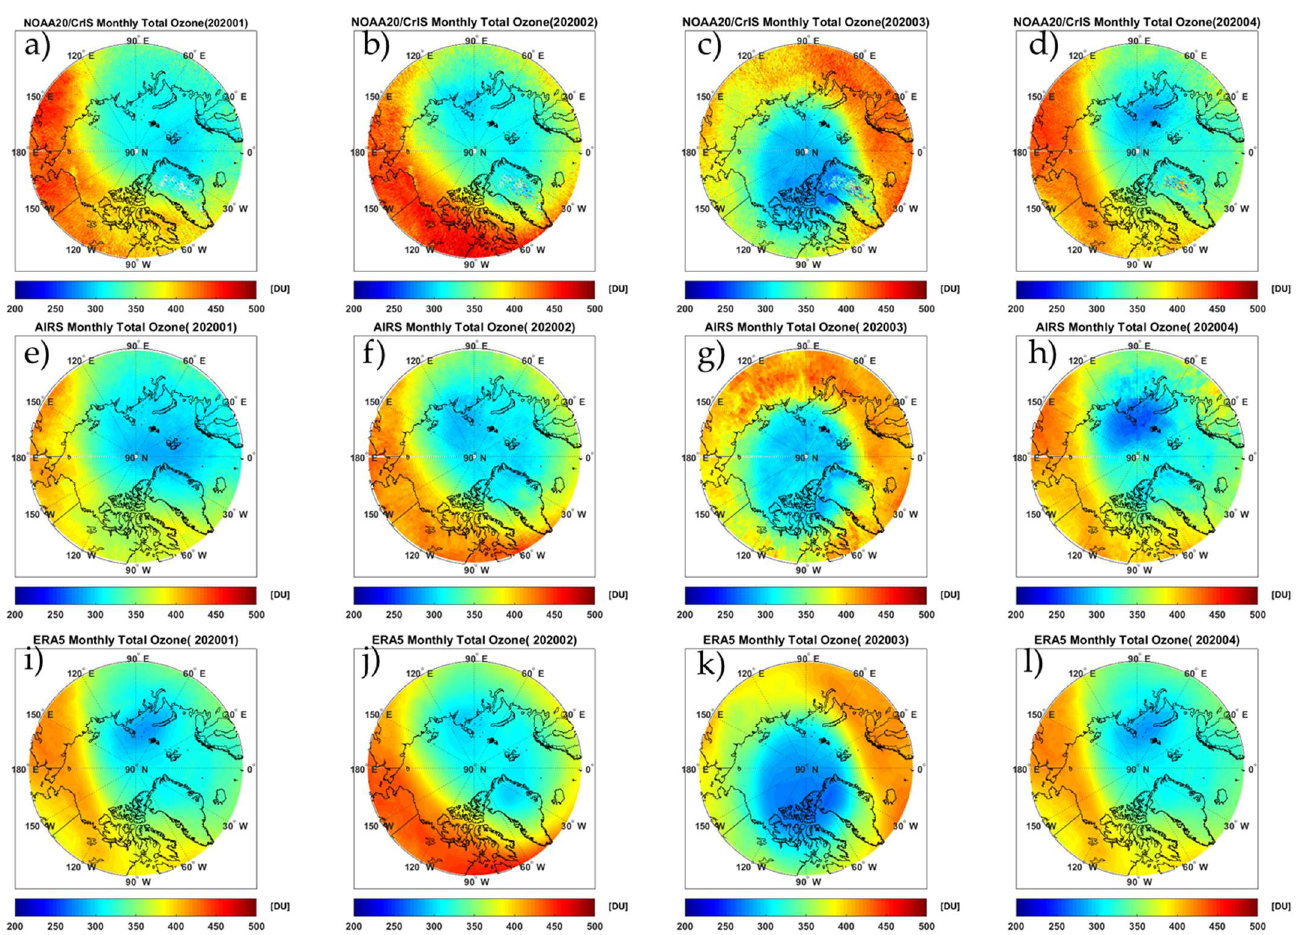
Figure 2. The distribution of total column ozone in the high latitudes of the northern hemisphere in January–April 2020. Upper: CrIS/NOAA20; Middle: AIRS/Aqua; Bottom: ERA5. January: ( a , e , i ); February: ( b , f , j ); March: ( c , g , k ); April: ( d , h , l ).